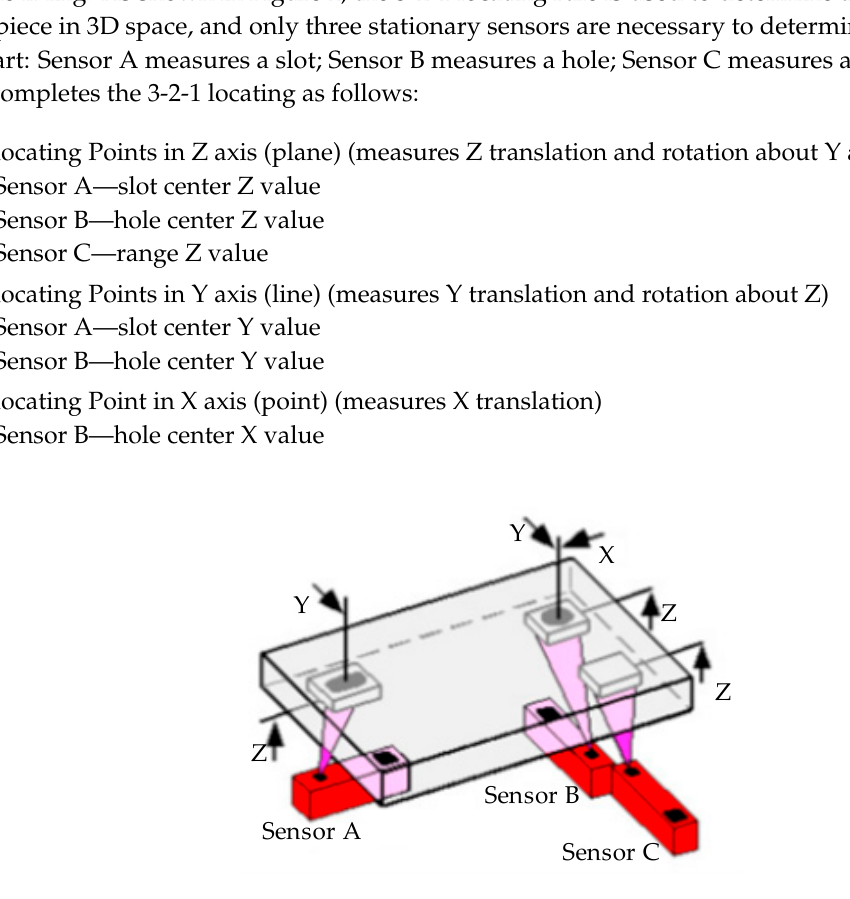
Figure 2. The 3-2-1 principle used to define workpiece frame (WF).